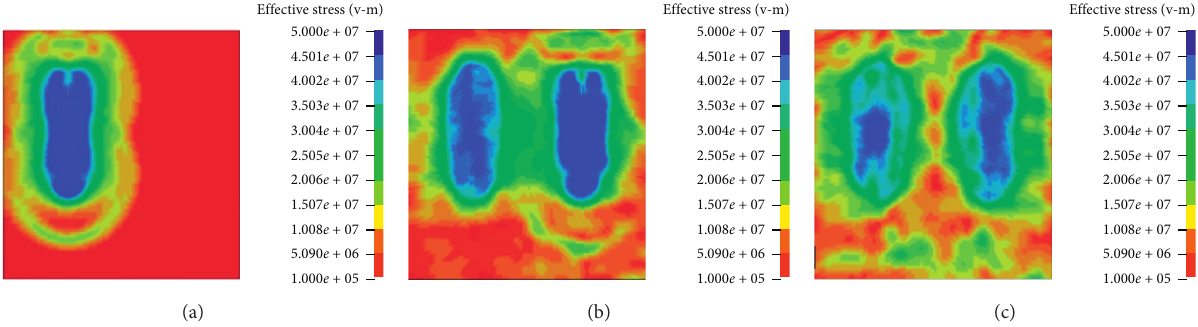
Figure 8: 13 m × 6m effective stress of the section between the front holes at different times. (a) t � 1.99ms. (b) t � 43.49ms. (c) t � 144.00ms.